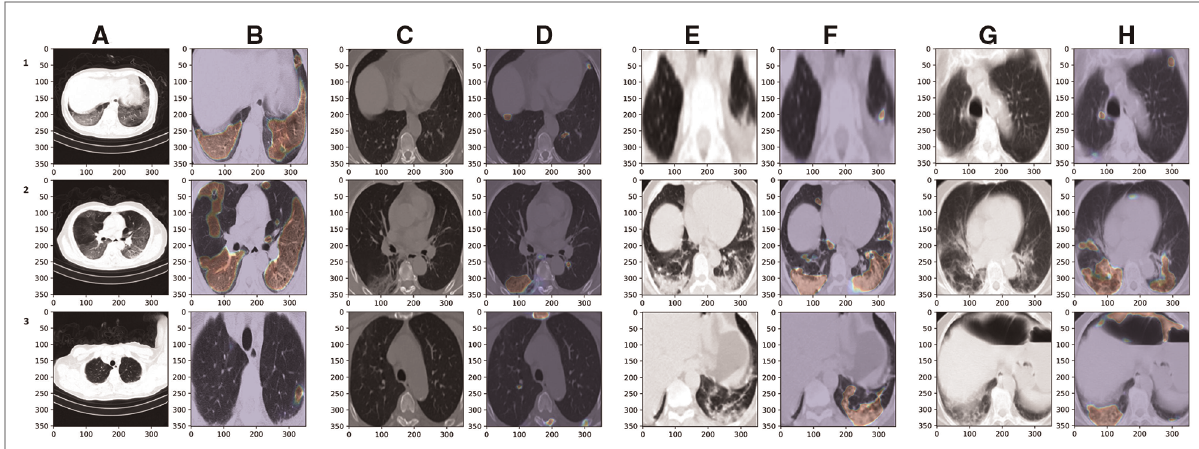
FIGURE 6 Axial CT study of four randomly sampled patients with COVID-19. Columns ( A ), ( C ), ( E )& ( G ) show the original images (columns C , E , & G segmented). Columns ( B ), ( D ), ( F ) & ( H ) show the bounding-box and lesion segmentation of the image at its left. Rows ( 1 ), ( 2 ) & ( 3 ) are different slices of the same patient at the start, middle and end of the study, respectively. The lesion quanti fi cation model determines the approximate lesion proportion, from top to bottom, as 59.11%, 56.49% & 11.30% for the fi gures on column ( B ); as 7.36%, 13.29% & 7.55% for those on column ( D ); as 15.61%, 40.72% & 38.11% for those on column ( F ); and as 11.73%, 27.91% & 79.97% for the slices on column ( H ). Note the patient on column ( C ), where the top and bottom slices show very little or no sign of lesions. That is the reason why it is necessary to process the complete CT volume. The Supplementary Material contains the fully processed studies for the four patients presented